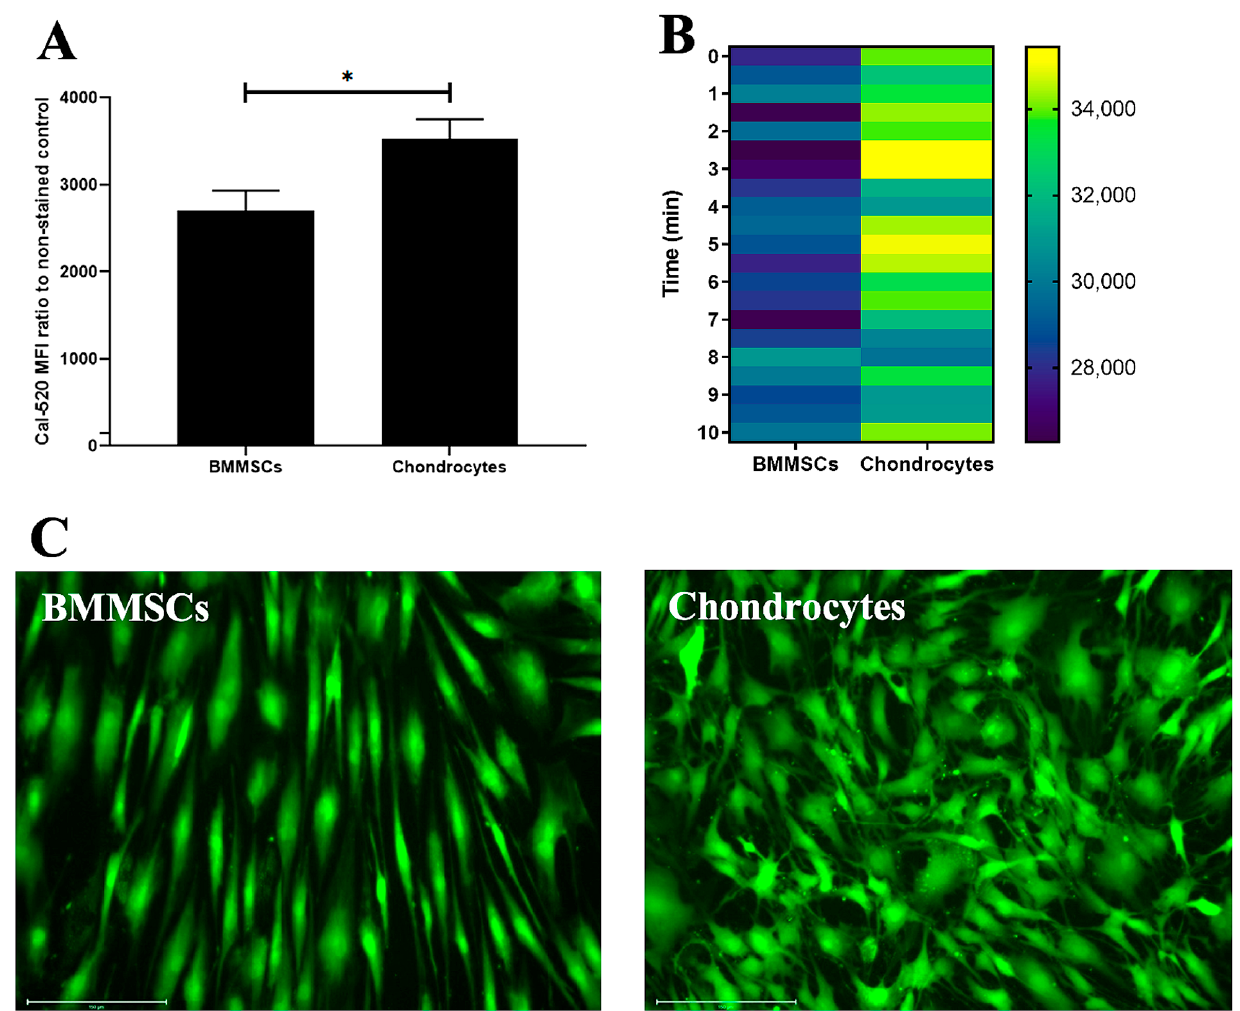
Figure 3. iCa 2+ in BMMSCs and chondrocytes stained with Cal-520. ( A ) Flow cytometry analysis showing medial fluoresce intensity (MFI) as ratio to non-stained cells (BD FACSAria). Data are shown as mean ± SD, n = 3 from not less than three different cultures of each type and are significant at * p ≤ 0.05. ( B ) iCa 2+ kinetics of BMMSCs and chondrocytes cultivated in a 2D monolayer, stained with Cal-520 and measured with a spectrophotometer (SpectraMax i3, Molecular Devices, San Jose, CA, USA). ( C ) The micrographs of BMMSCs and chondrocytes cultivated in a 2D monolayer, stained with Cal-520 dye and measured with an EVOS fluorescent microscope (Waltham, MA, USA). Scale bar 200 μ m.